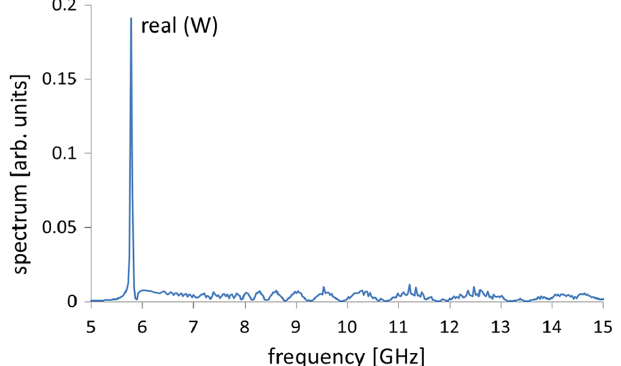
3.FIG. 7. Spectrum of the excited fields (real part) in the IR model 1.